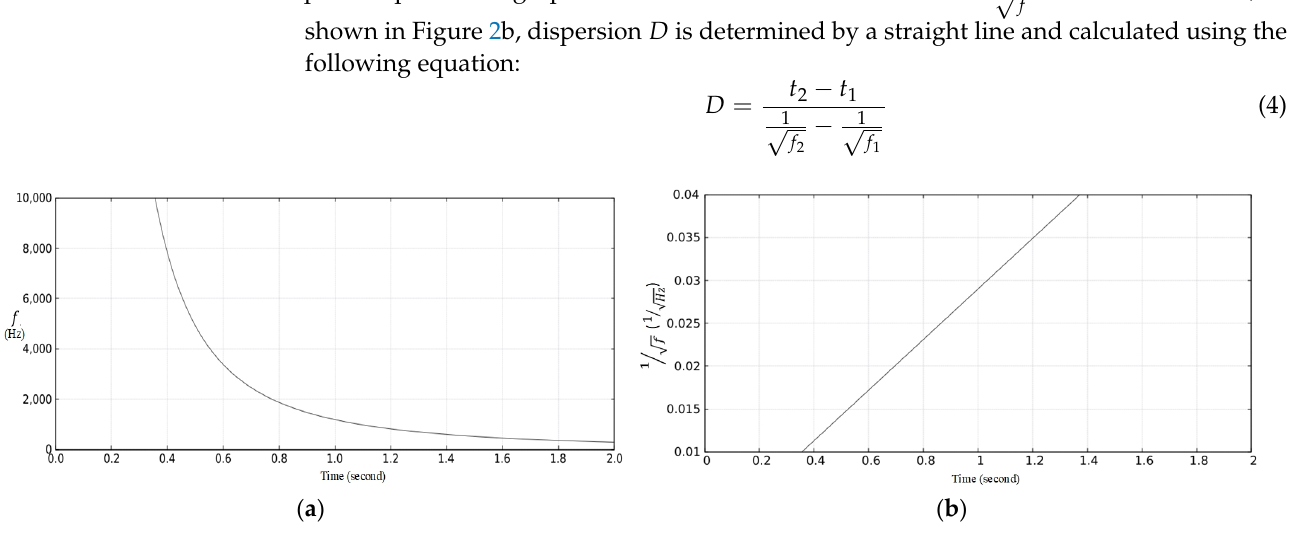
Figure 2. ( a ) Dynamic power spectra of a lightning whistler. ( b ) Converted dynamic power spectra of a lightning whistler.